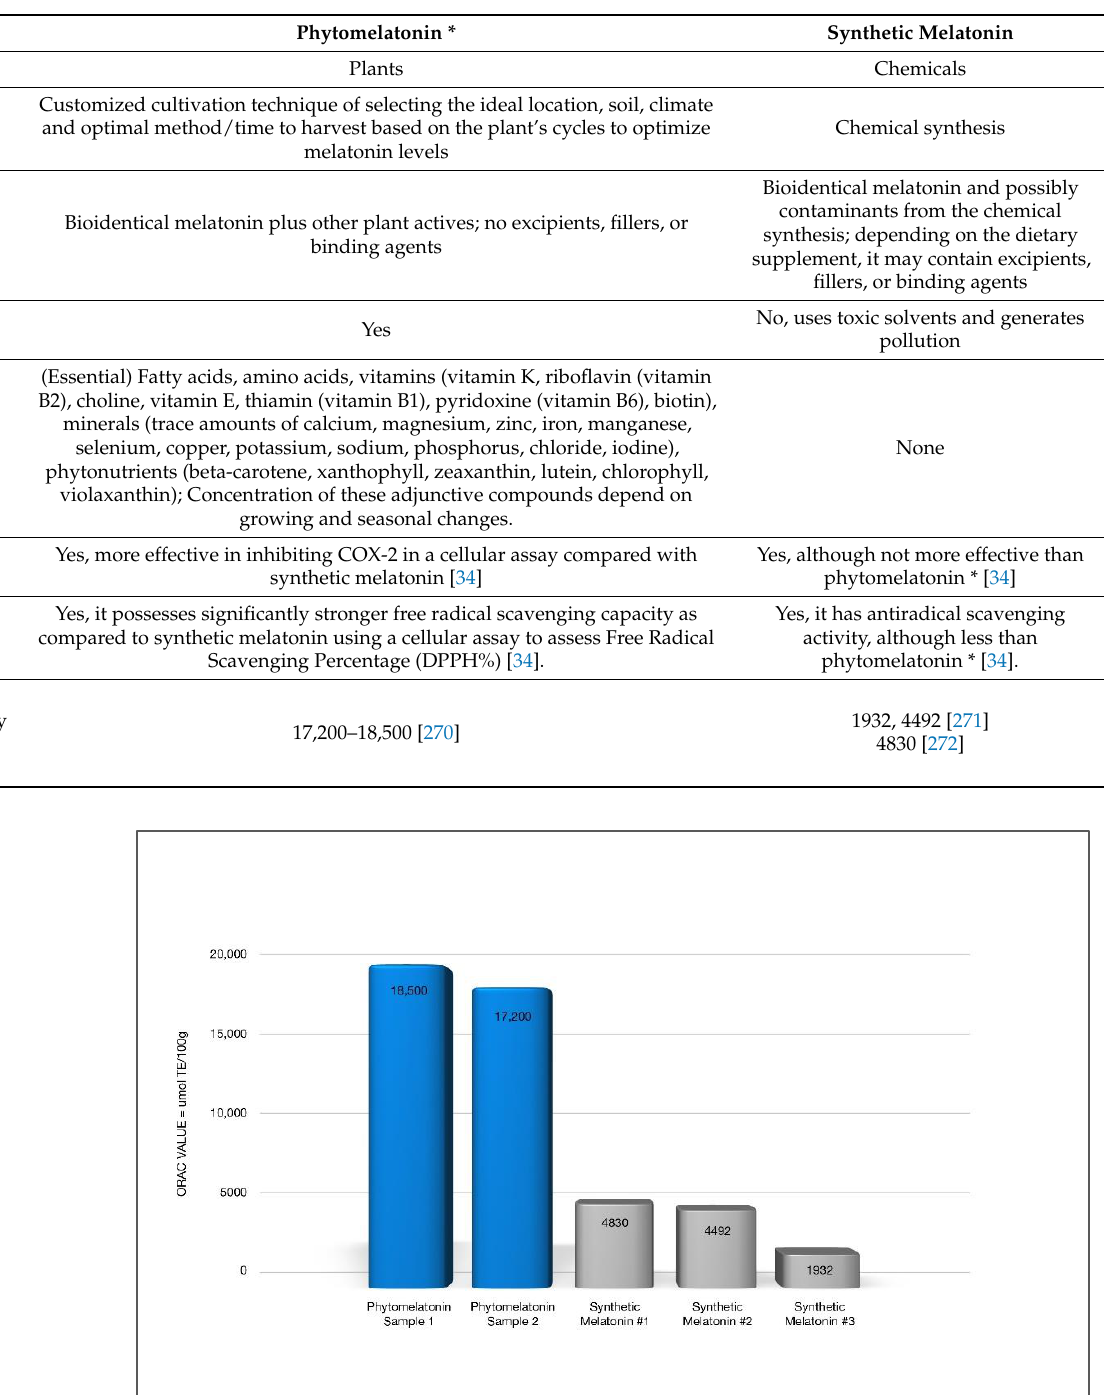
Table 5. Comparison between phytomelatonin and synthetic melatonin. * The phytomelatonin used for comparison is the proprietary format utilized in [34].